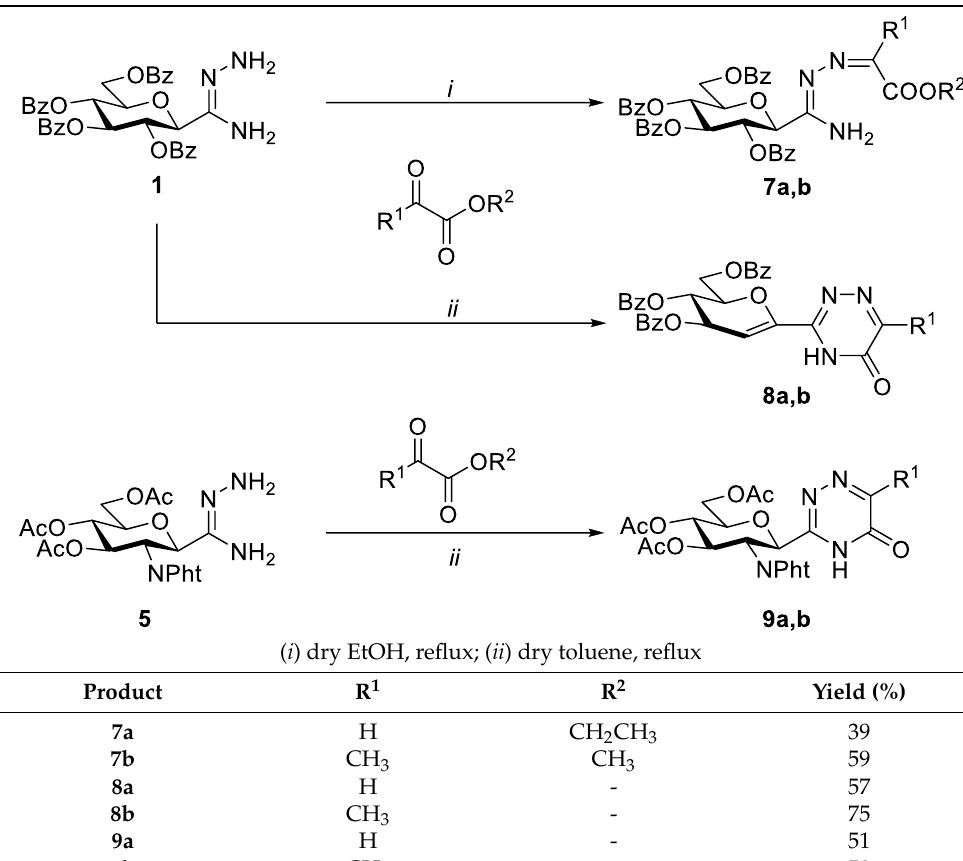
Table 3. Synthesis of 3-glycopyranosyl-1,2,4-triazin-5(4 H )-ones.